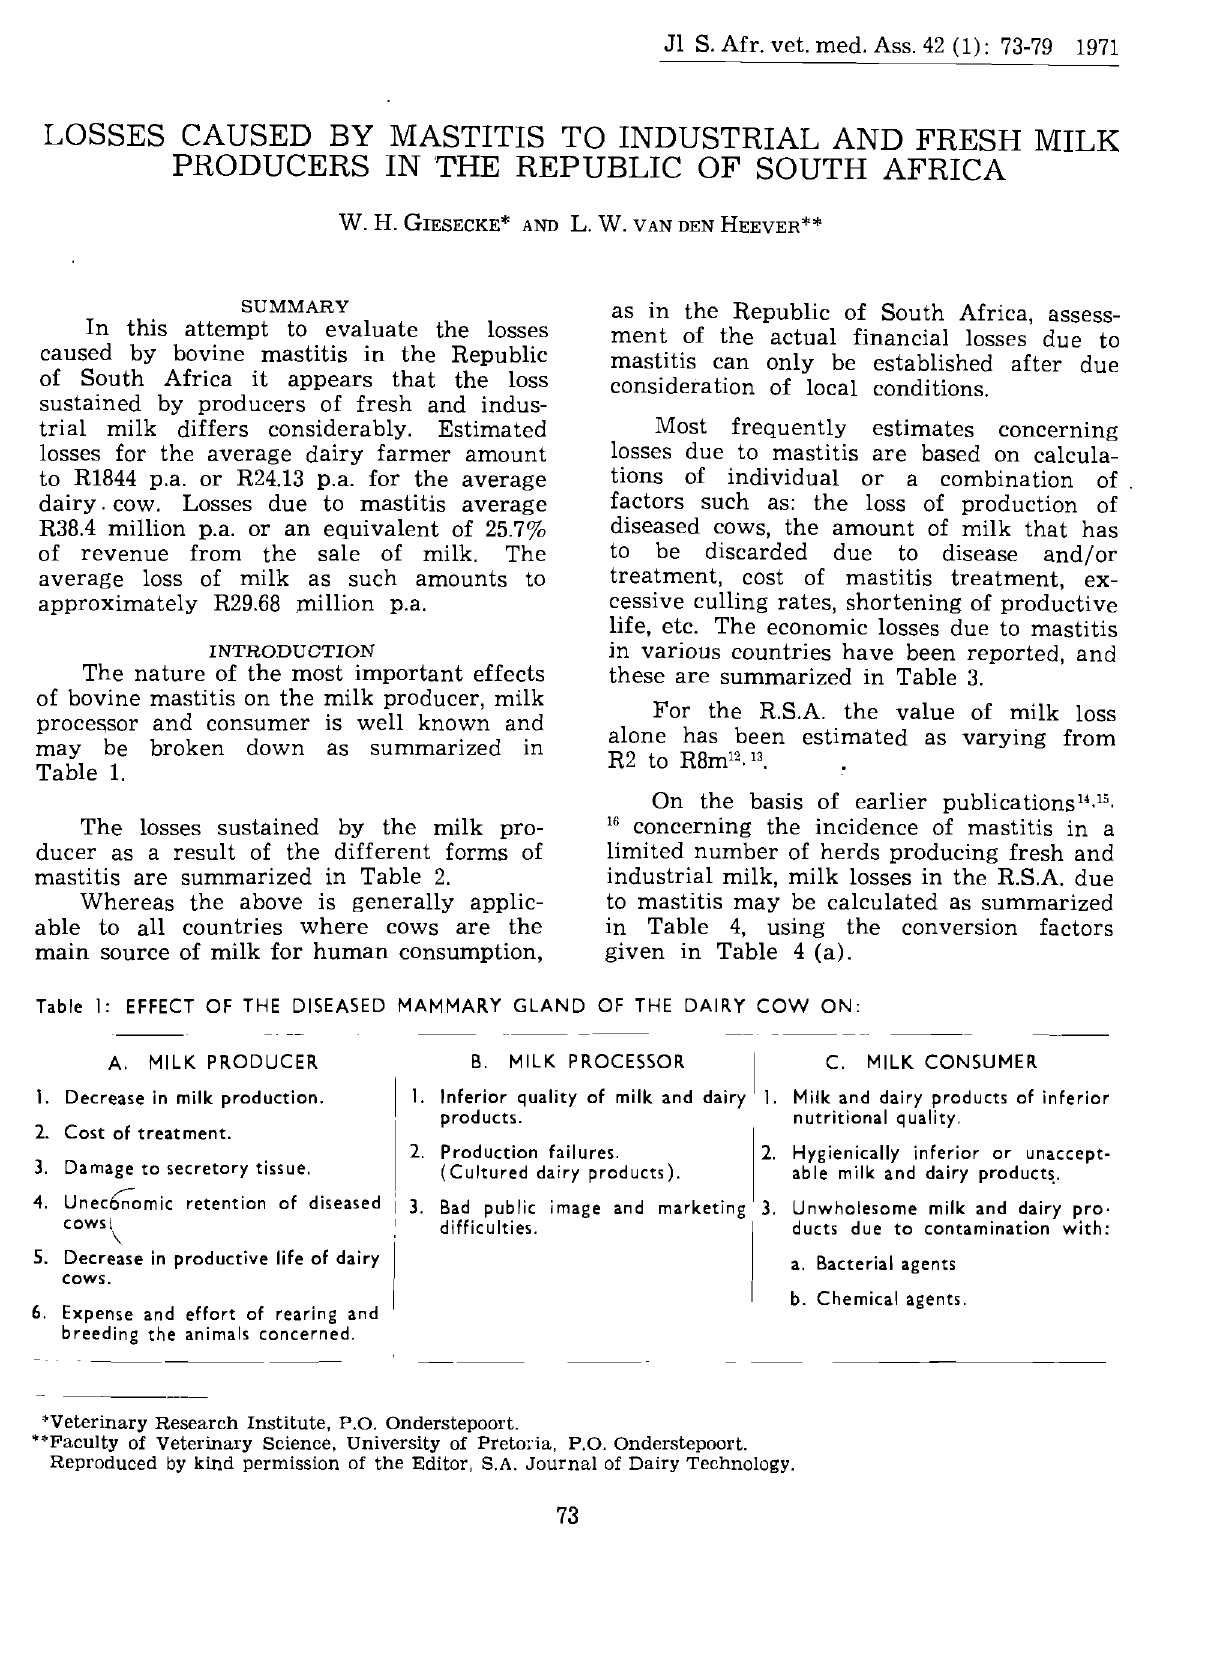
Table I: EFFECT OF THE DISEASED MAMMARY GLAND OF THE DAIRY COW